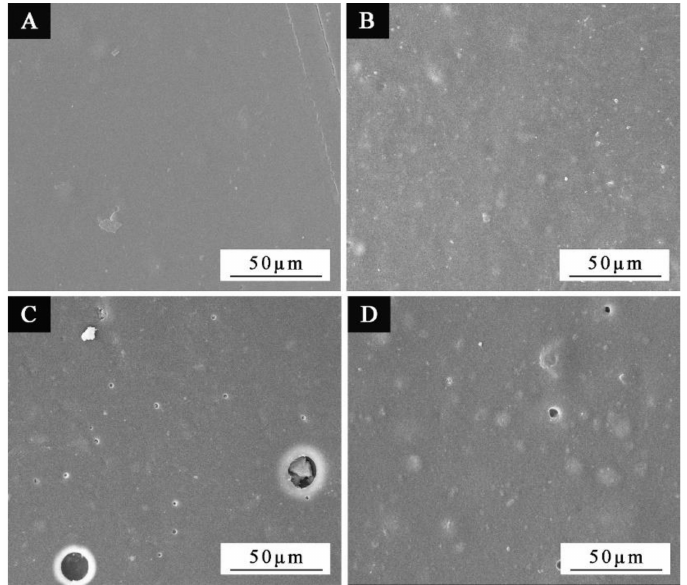
Figure 8. SEM images of coating films with and without microcapsules before and after UV ag- ing: without microcapsules ( A ) before aging, ( C ) after aging; with microcapsules ( B ) before aging, ( D ) after aging.